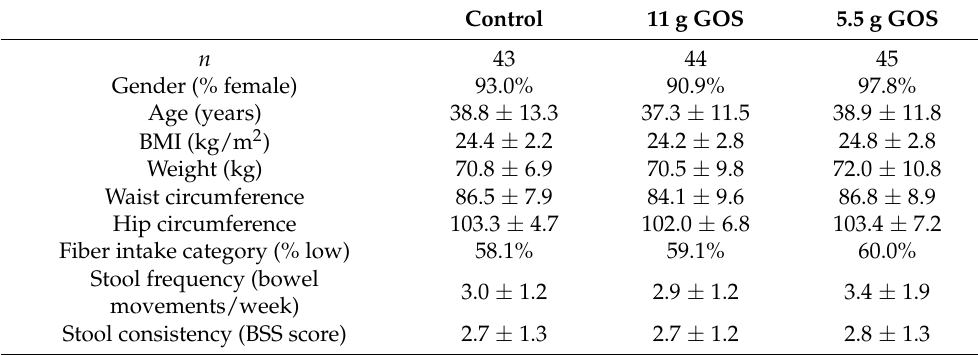
Figure 1. Flow diagram. Table 2. Baseline characteristics of ITT Population (presented as means ± SE or percentage). BSS = Bristol Stool